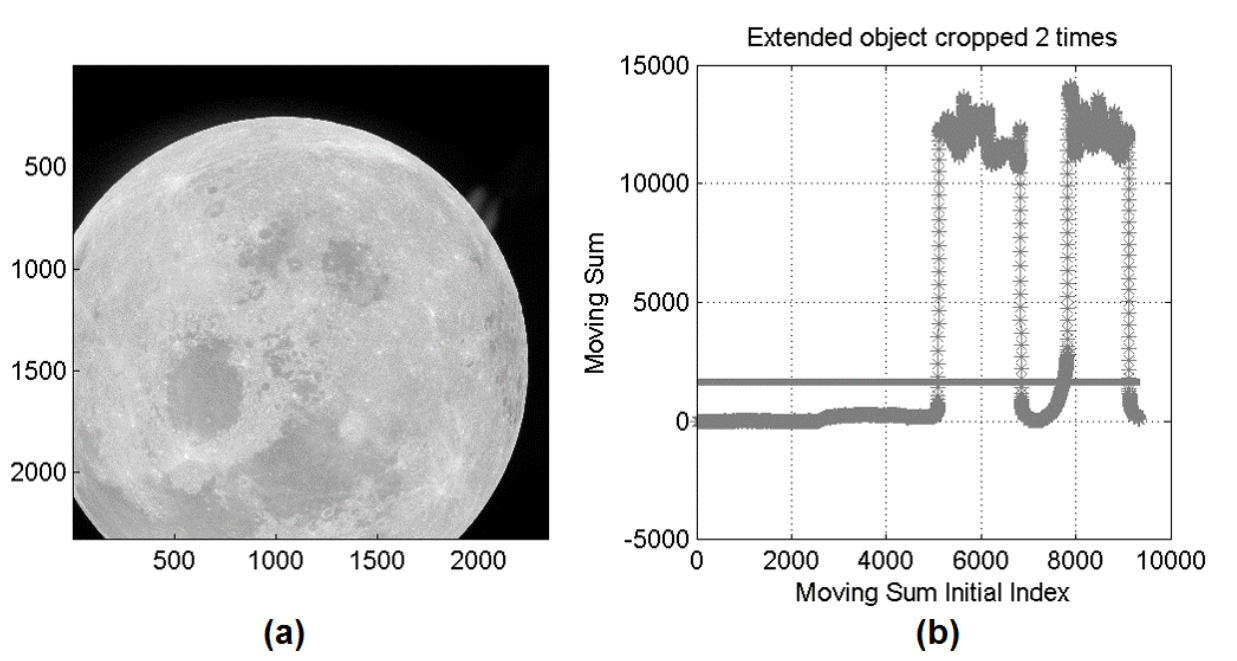
Figure 6. Processing of a cropped image. ( a ) Cropped image of the Moon; ( b ) Results of the cropped